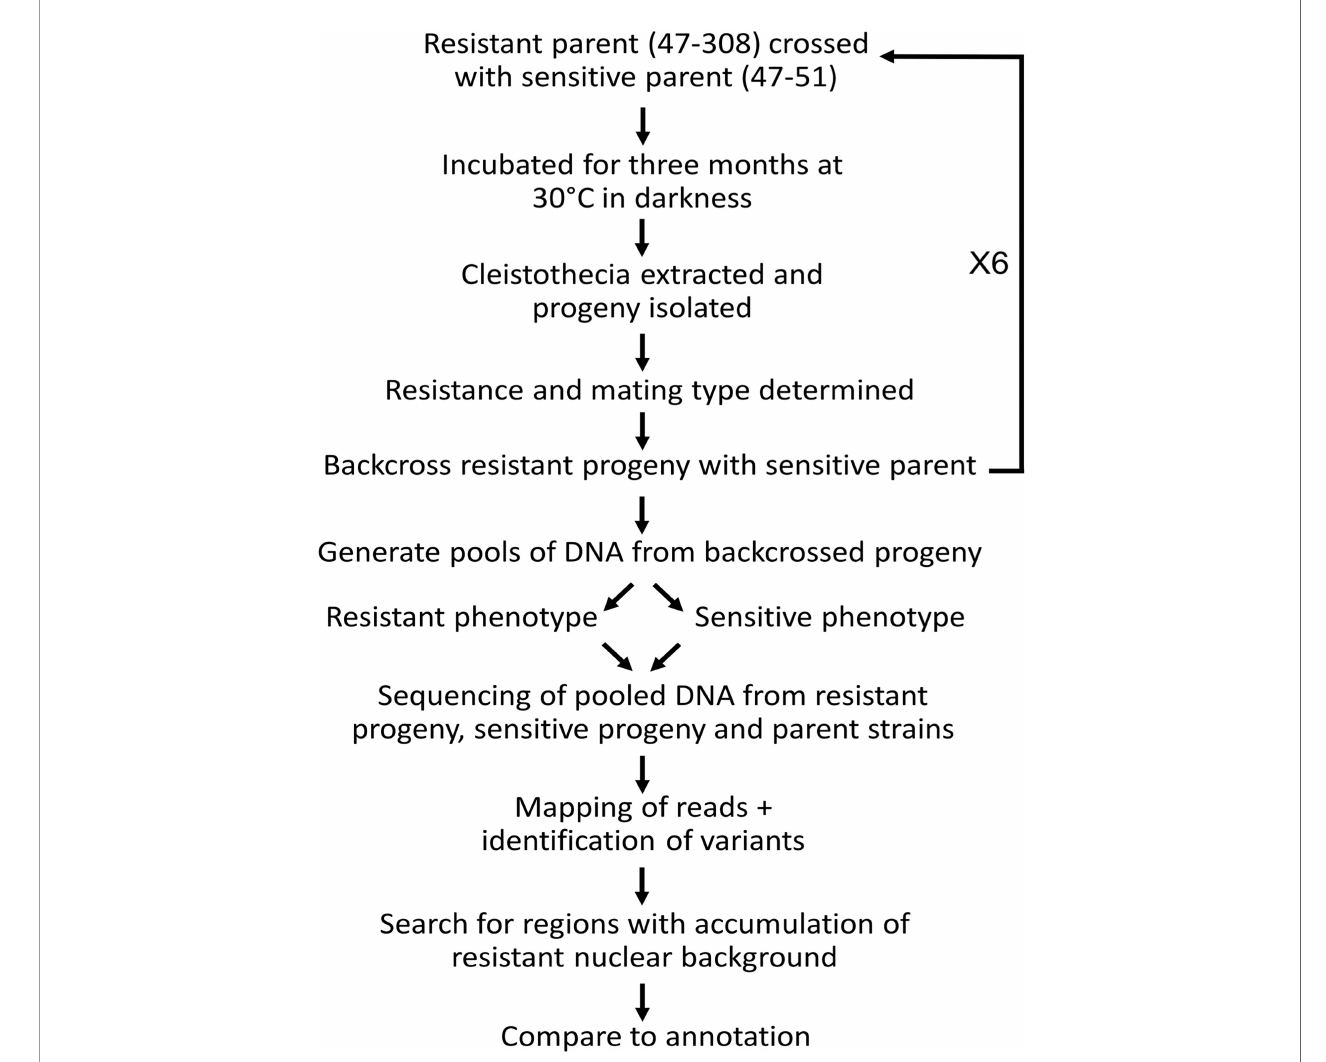
FIGURE 2 | Methodology of bulk segregant analysis used in the present study. An azole resistant isolate (47-308) carrying an unknown mutation was sexually crossed with a sensitive isolate (47-51). F1 progeny were collected and up to six rounds of backcrossing with the sensitive parent undertaken with arising resistant progeny. At certain stages the collected progeny were separated into azole resistant and sensitive pools, which were genome sequenced in order to identify genomic regions within the resistant progeny containing a candidate gene(s) of